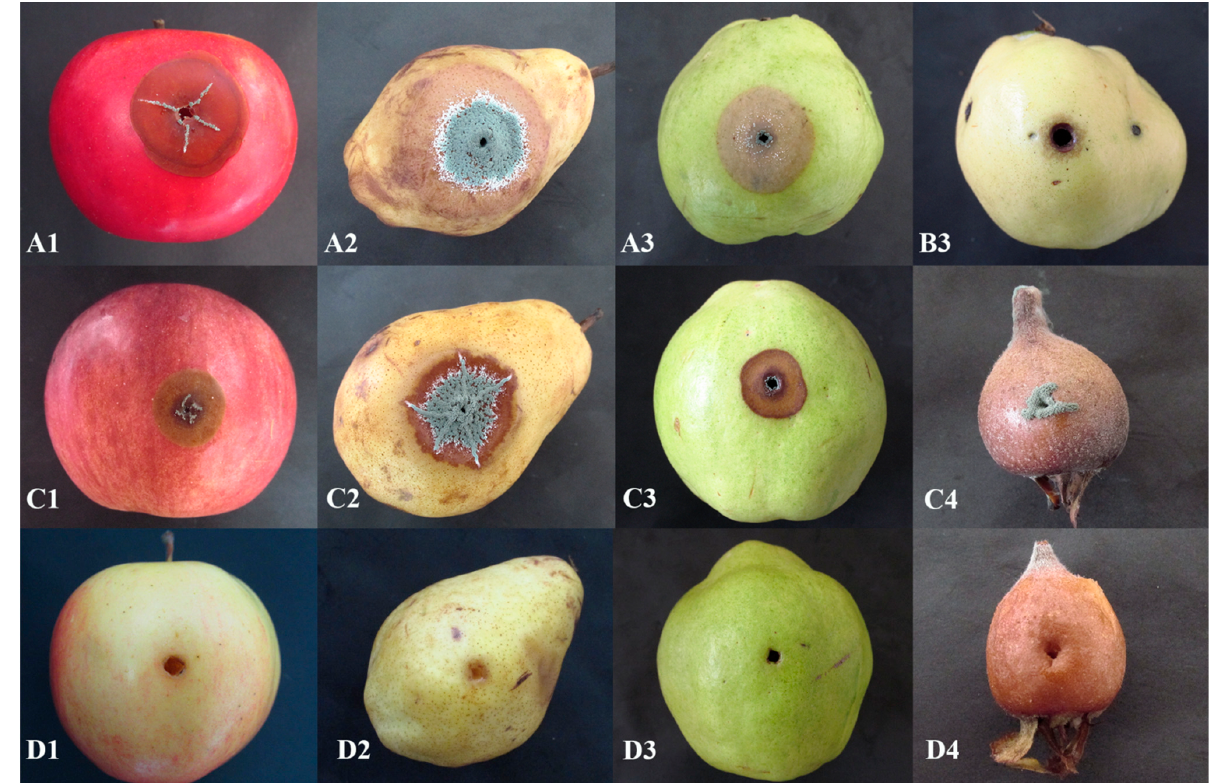
Figure 2. Blue mold on pome fruits: apple (1), pear (2), quince (3), and medlar (4) inoculated with representative isolates of P. expansum ( A ), P. solitum ( B ), P. crustosum ( C ), and uninoculated control ( D ).